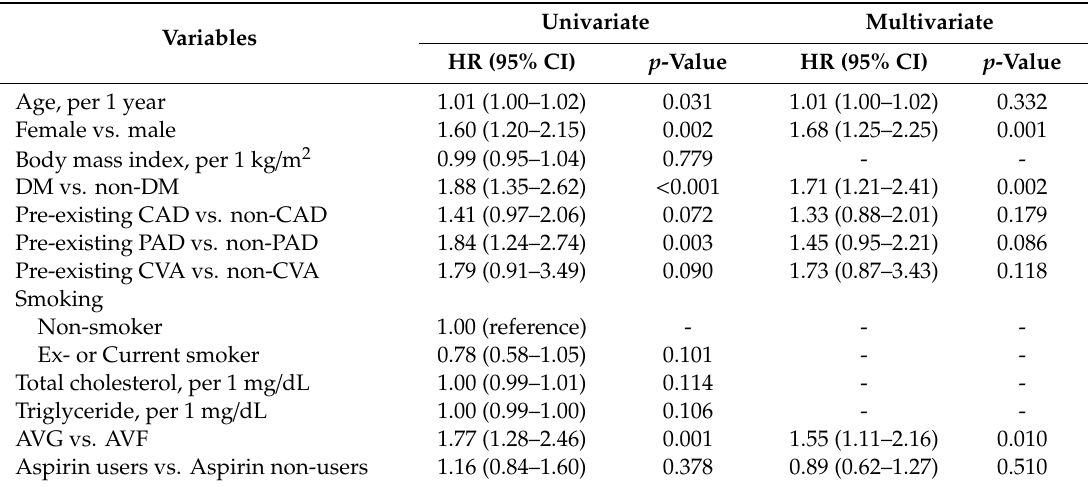
Table 2. Cox proportional regression analysis for vascular access failure event (primary outcome).